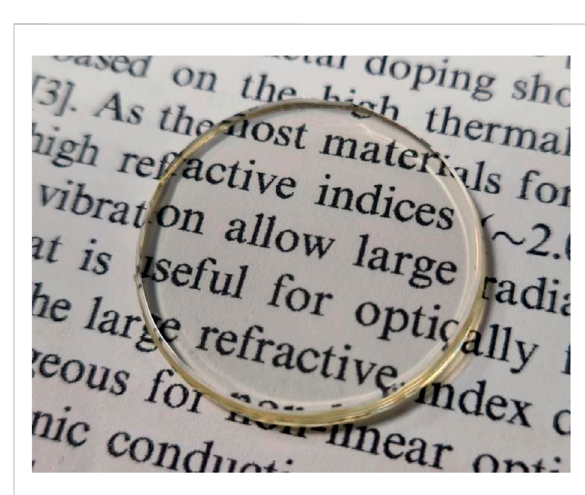
FIGURE 4 Physical appearance of synthesized C40 (40% mol CdO)